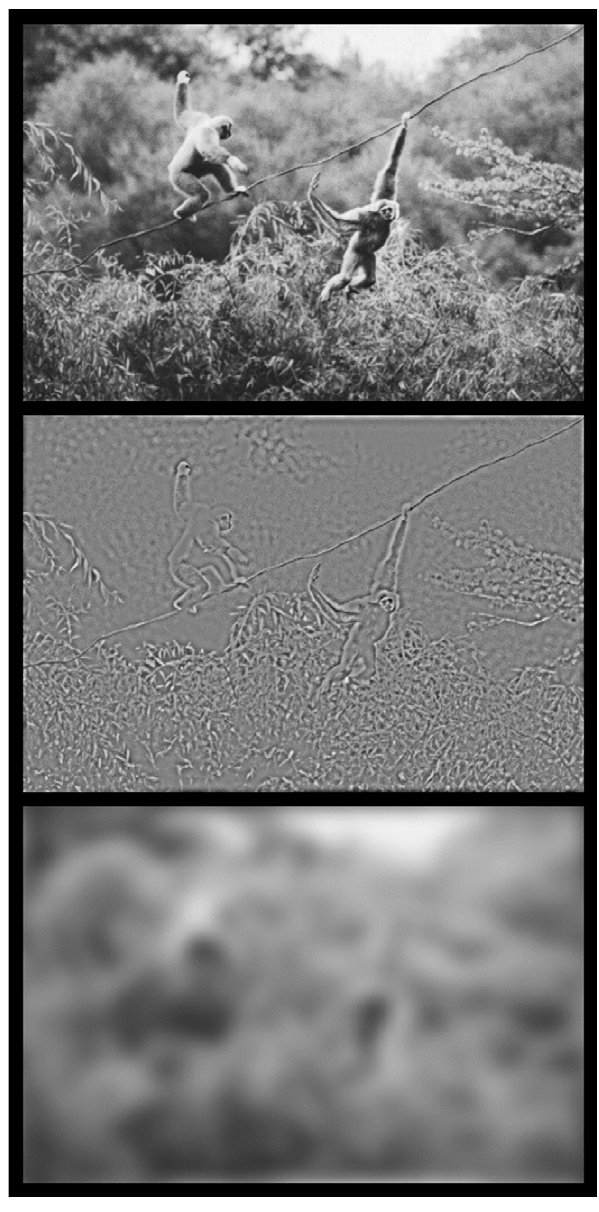
Figure 10. Detection of high SFs is crucial for primate place perception. The top panel shows an image of two apes (gibbons) navigating through the forest canopy. The middle and bottom panels show the same image, when filtered for high and low SFs, respectively. The high SFs highlight the borders of the branches and vines, but those borders are essentially invisible in the low SF image. In the normal image (top), the borders are arguably less identifiable than in the high SF image, due to competing visual clutter. The ability to exactly localize the borders of these environmental features has obvious survival value. The original image was taken from [50] with